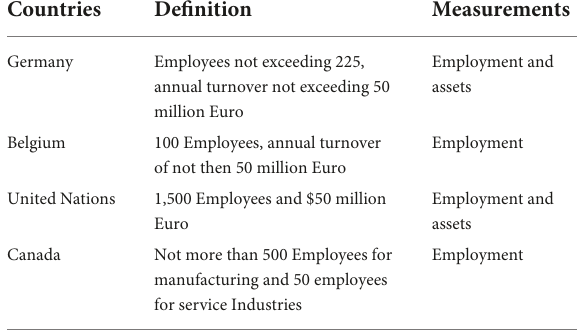
TABLE 2 The worldwide description of